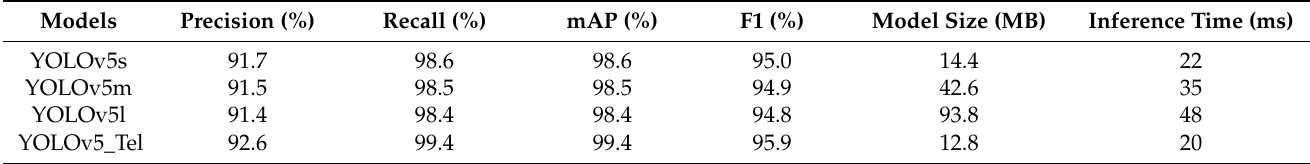
Table 3. The simulation results of different YOLOv5